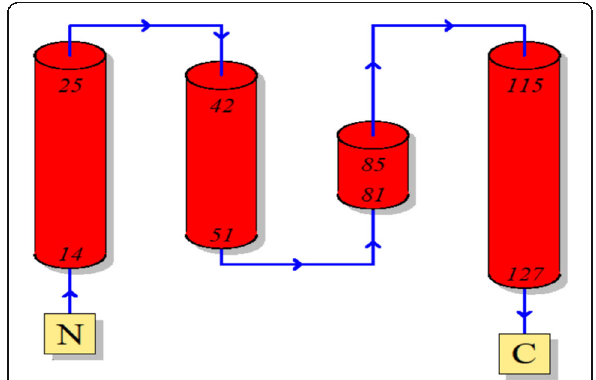
Fig. 17 The topology diagram of the structural domain in S.AMP13. The diagram shows the relative location of the α -helices represented by the red cylinders, and the blue color arrow indicates the directionality of the protein chain from the N- to